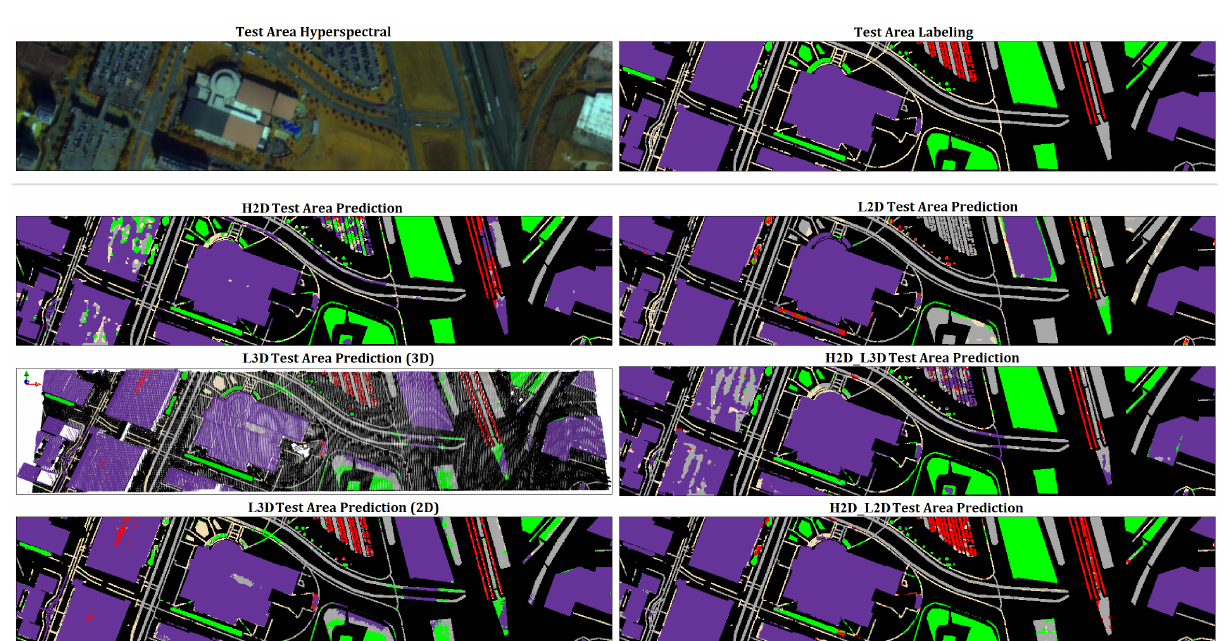
Figure 9. Combined test sample predictions over the entire test set area for all models. ( Row